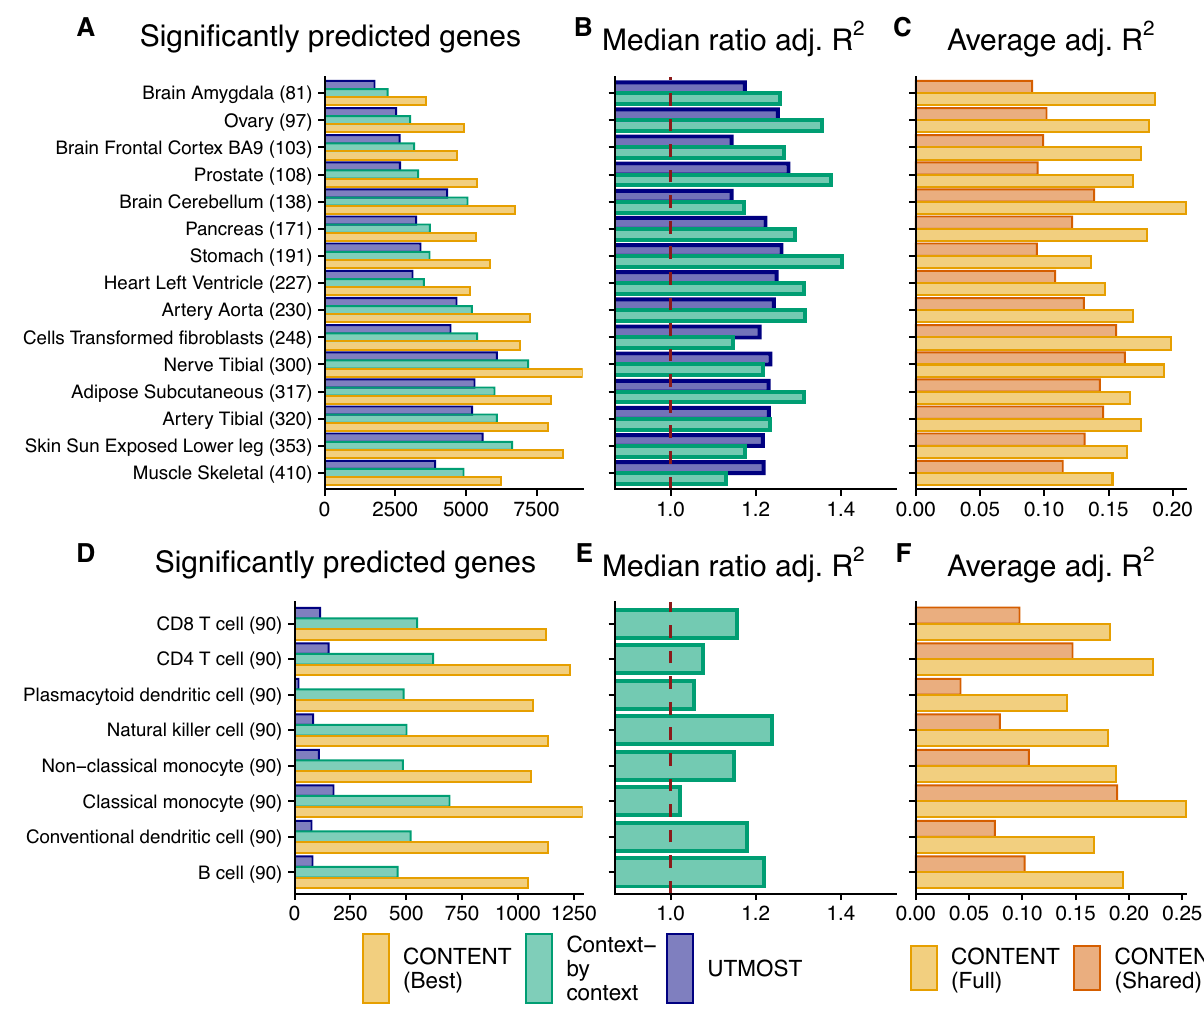
Fig. 3 | CONTENToutperformsexisting approachesinthe GTEx and scRNA-seq CLUESdatasets.A , D Numberofgeneswithasigni fi cantlypredictablecomponent (hFDR ≤ 5%) in GTEx ( A ) and CLUES ( D ); the sample sizes for each context are included inparentheses. B , E Ratioof expressionprediction accuracy(adjusted R 2 ) of the best-performing cross-validated CONTENT model over the context-by-